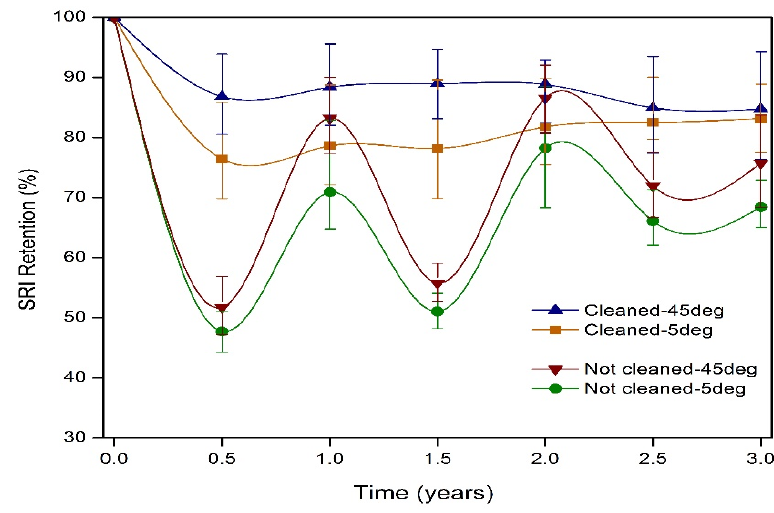
Figure 11. Percentage retention of SRI values as function of exposure period.